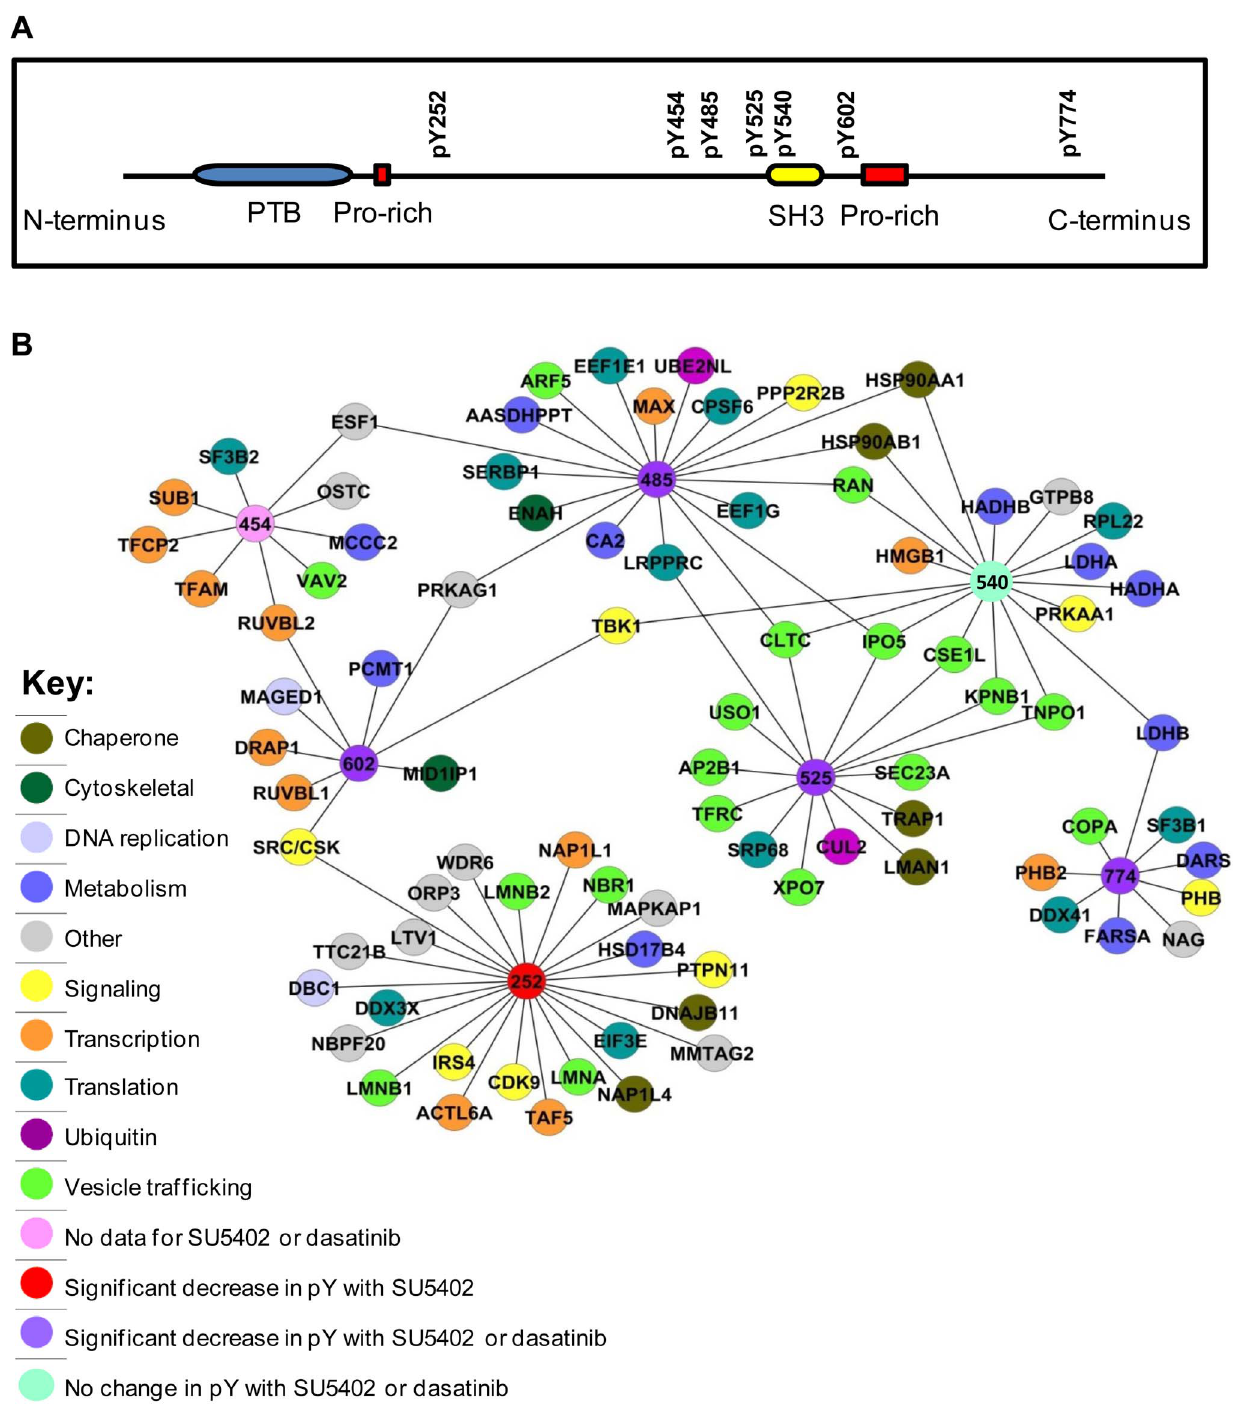
Figure 4. Protein-peptide interaction network for proteins binding specifically to phosphotyrosine-containing Eps8 peptides. A) Schematic diagram showing locations of the pY residues within the domain structure of Eps8. B) Using SILAC we carried out quantitative peptide pull-down assays from FGF2 stimulated (20 ng/ml; 15 min) HEK 293T cells to compare protein-peptide interactions for phosphotyrosine versus non- phosphotyrosine containing Eps8 peptides. Proteins interacting preferentially to phosphotyrosine peptides have been plotted in an interaction network. doi:10.1371/journal.pone.0061513.g004 Peptides were loaded onto an Acclaim PepMap 100 C18 resolving column (15 cm length;75 m m internal diameter; LC Packings, On-line liquid chromatography was performed by use of an USA) and separated over a 40 minute gradient from 3.2% to 44% Dionex Ultimate 3000 LC system (Thermo Fisher Scientific).